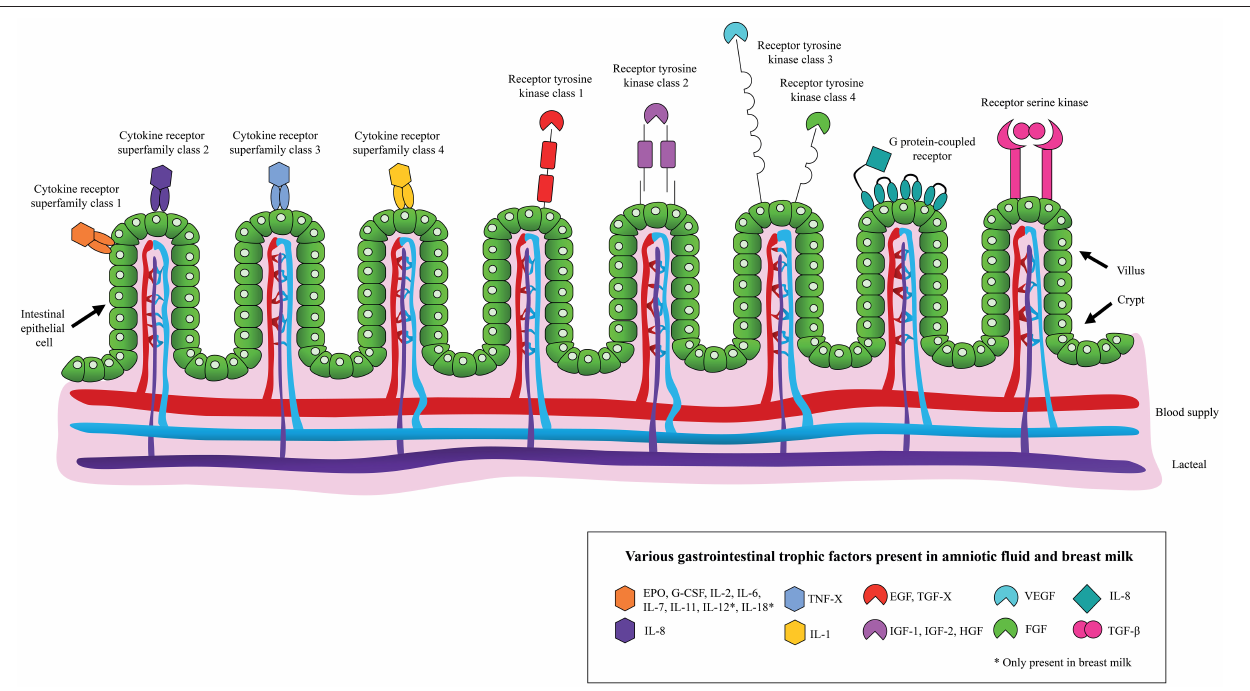
FIGURE 1 | Schematic overview of the binding of various gastrointestinal trophic factors, present in amniotic fluid and/or breast milk, to the neonatal intestinal epithelium.